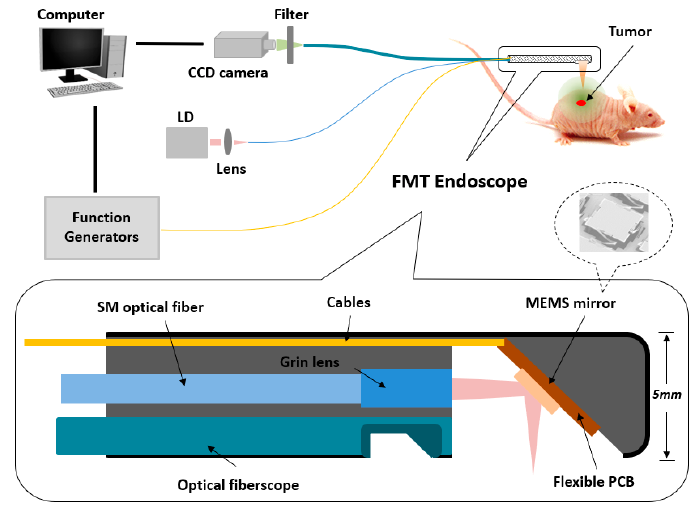
Figure 6. Schematic of the miniaturized FMT endoscopic system.